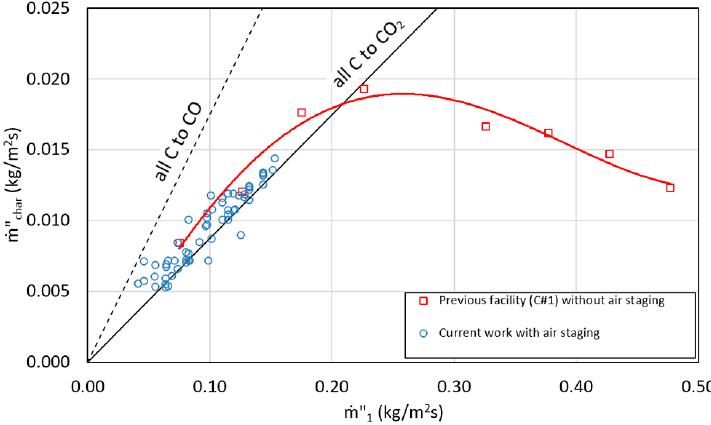
Figure 8. Relation between char burning rate and primary airflow rate with and without air